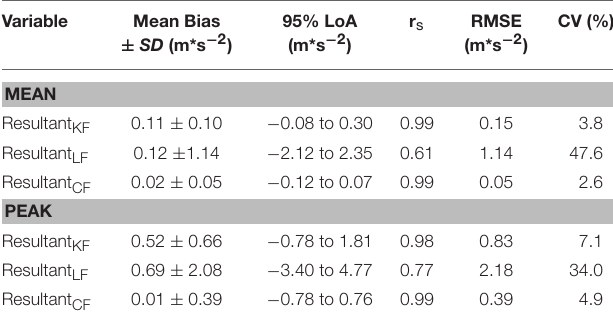
acceleration values in all axes ( Figure 3 ) but still are within an acceptable range.